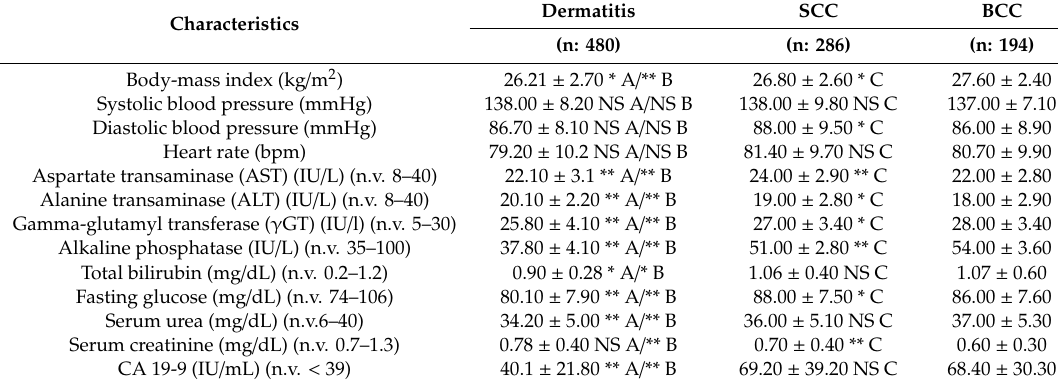
Table 2. Parameters and biochemical characteristics of the study cohort (values are expressed as the mean ± SD). A: Comparison of dermatitis and SCC; B: Comparison of dermatitis and BCC; C: Comparison of SCC and BCC. Statistical significance: * p < 0.05, ** p < 0.001, NS =